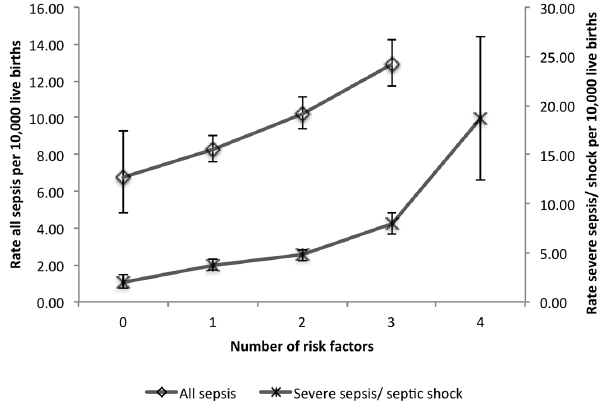
Figure 1. Absolute risk (95% CI) of all sepsis and severe sepsis/ septic shock as a function of the number of apriori risk factors.